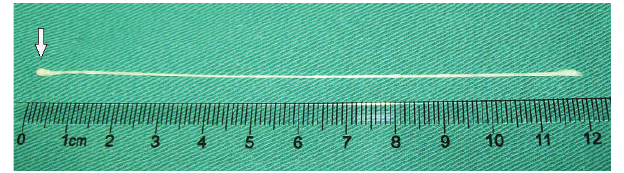
Figure 2 - A live tapeworm with the scolex, measuring approximately 12 cm in length, extracted from the patient (arrow).